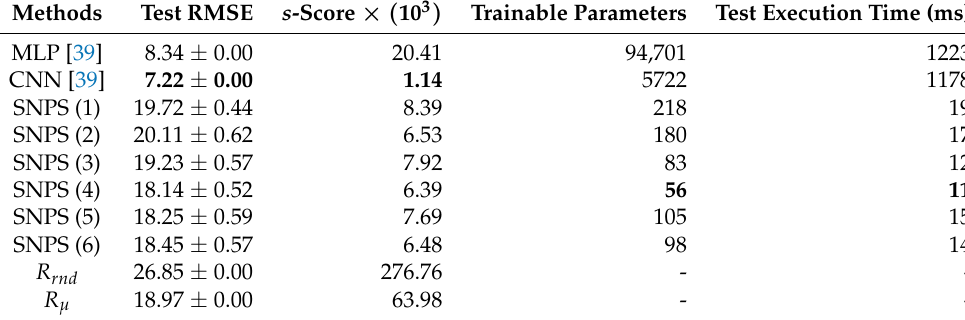
Table 8. Summary of the comparative analysis based on the test results on N-CMAPSS (DS02). The symbol “-” indicates not available data. For our SNPS methods, we report the RMSE in terms of mean ± std. dev. across 10 independent runs. For the remaining methods, we report the results from the original papers (std. dev. not provided). The boldface indicates the best value per